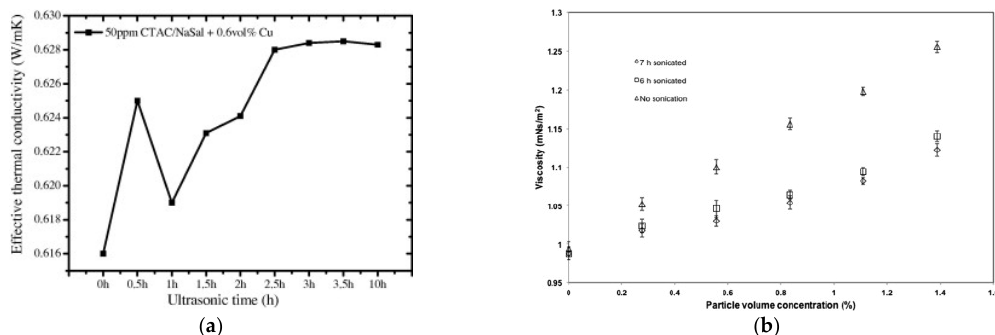
Figure 9. Effect of ultrasonication time on ( a ) thermal conductivity [53] and ( b ) viscosity [28] for different nanofluids.